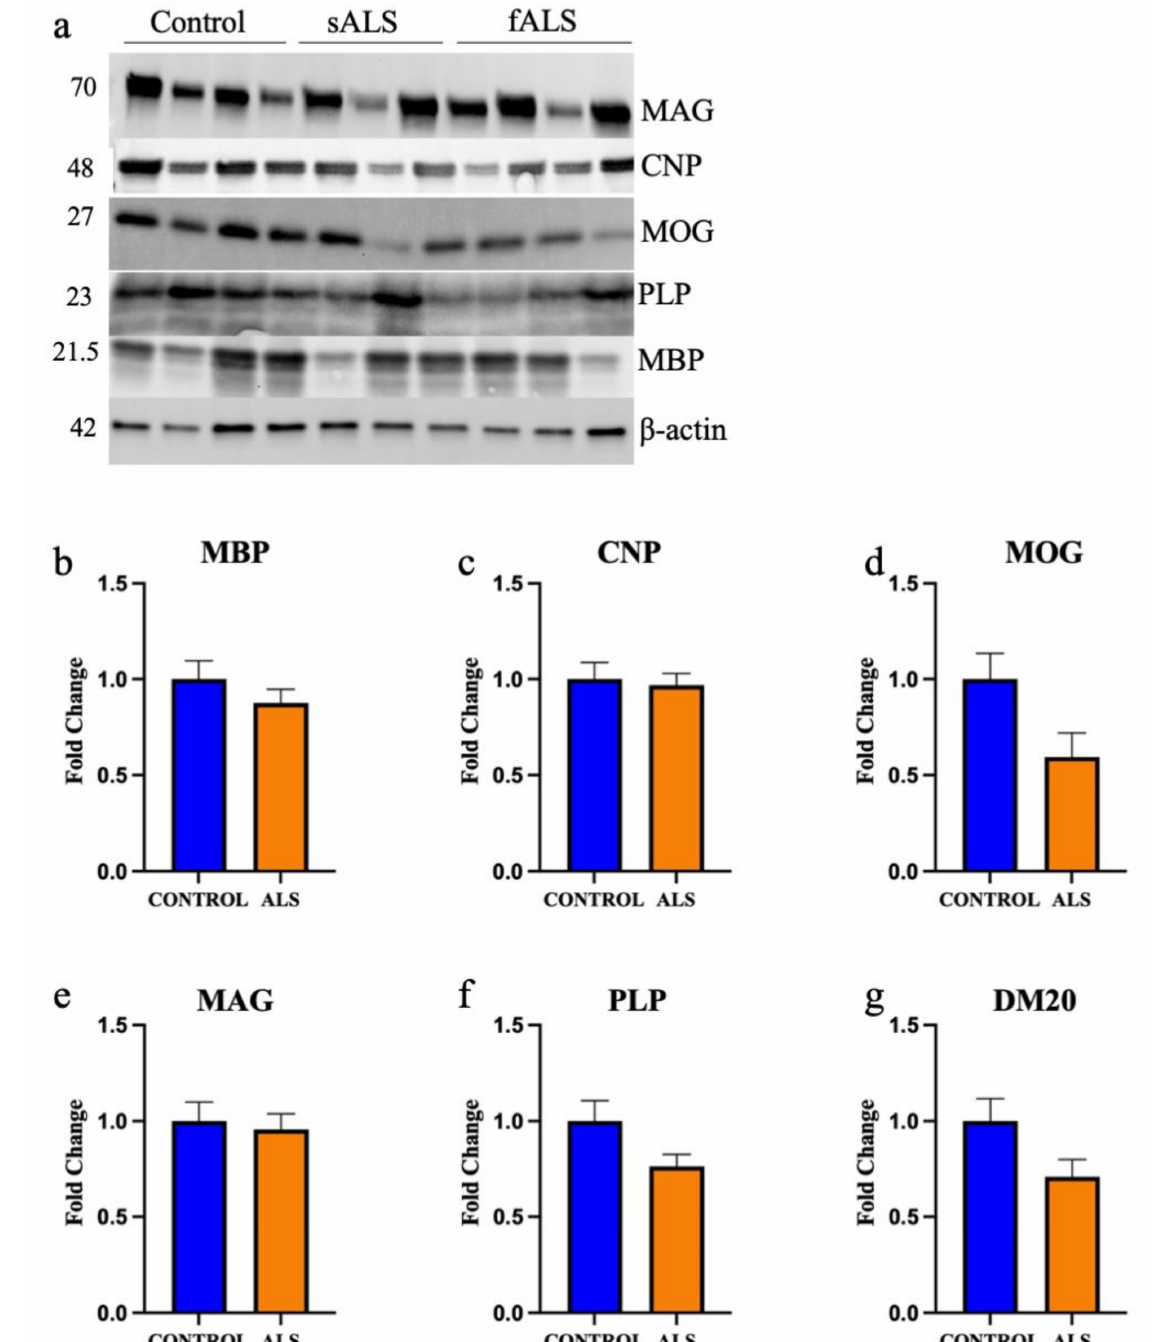
Figure 7. The protein expression of key myelin proteins is not altered in the motor cortex white matter in ALS. ( a ) A representative blot of key myelin proteins measured using Western blot in sALS, fALS and control. Numbers denote protein size in kDa. The protein expression of ( b ) myelin basic protein (MBP); ( c ) 2’,3’-Cyclic-nucleotide 3’-phosphodiesterase (CNPase); ( d ) myelin oligodendrocyte glycoprotein (MOG); ( e ) myelin-associated glycoprotein (MAG); ( f ) proteolipid protein (PLP); and ( g ) DM-20 are not different in ALS (sALS n = 8 and fALS n = 6 combined; orange) compared to control (n =